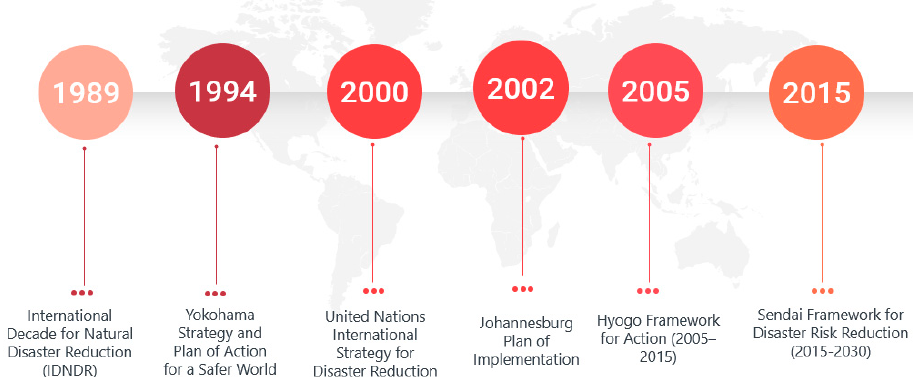
Figure 1. Disaster risk reduction frameworks.